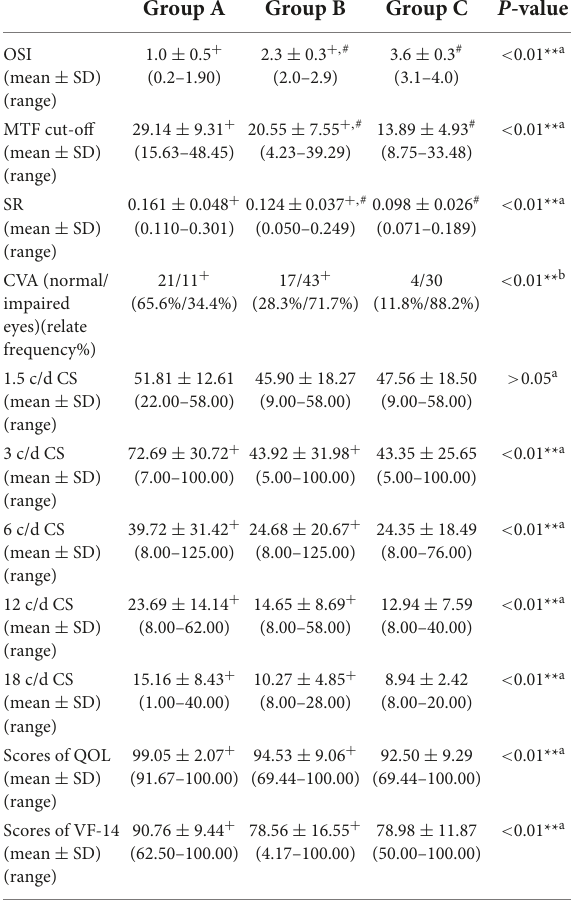
TABLE 2 Objective and subjective visual function indexes of the three